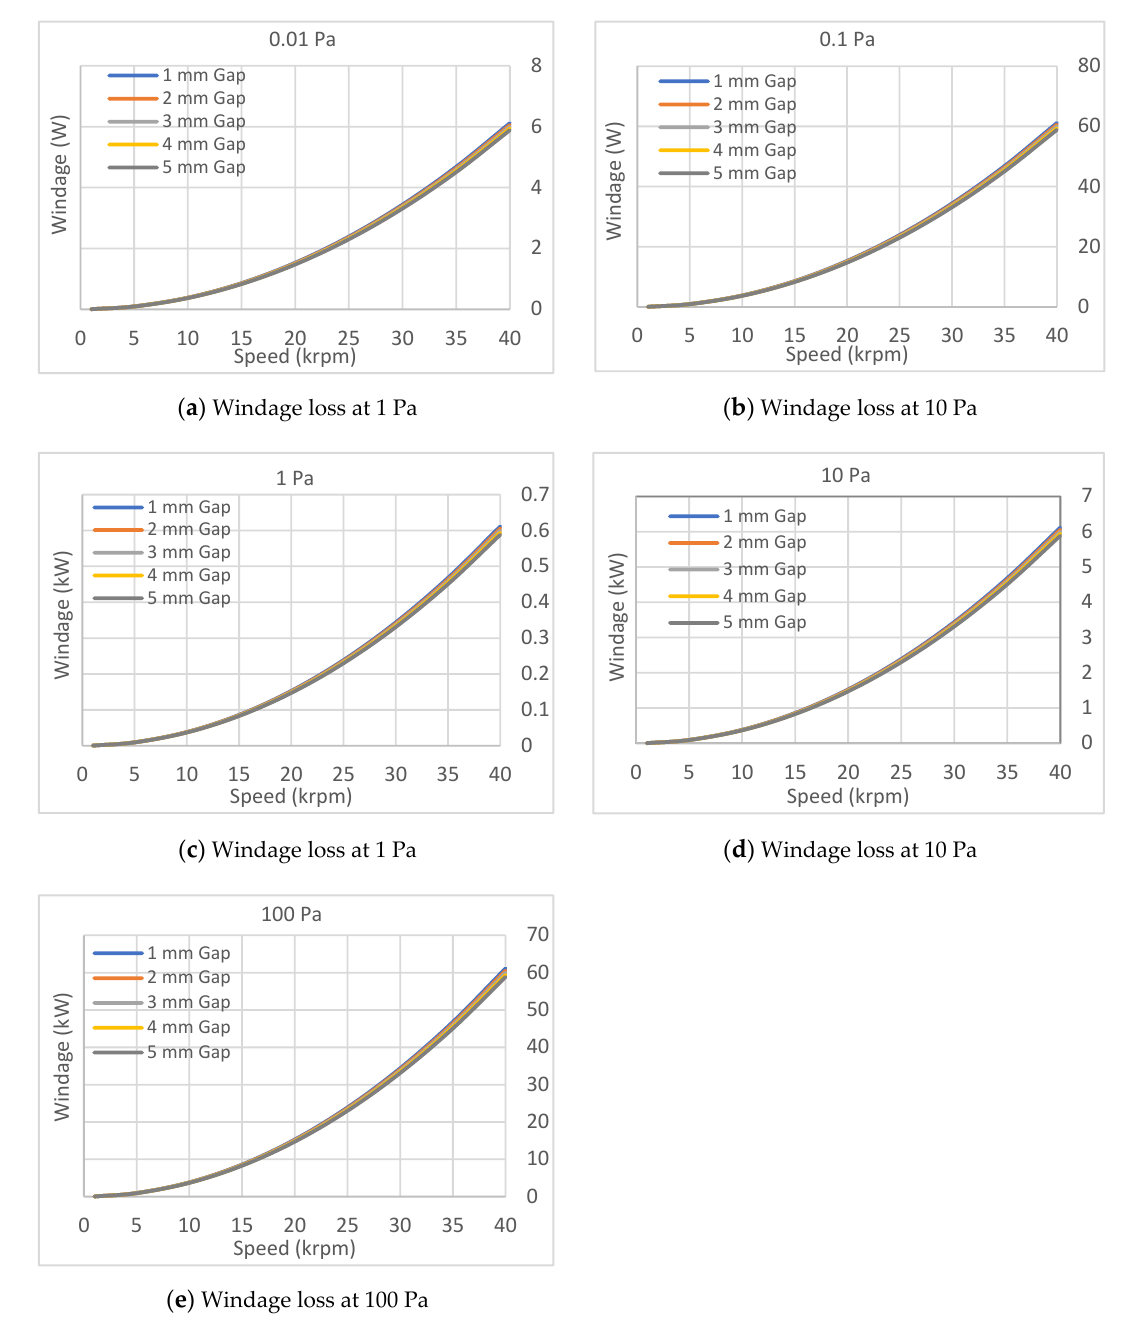
Figure 7. Windage loss relative to pressure and speed at different air gaps–Method 2 (with 𝜎 )